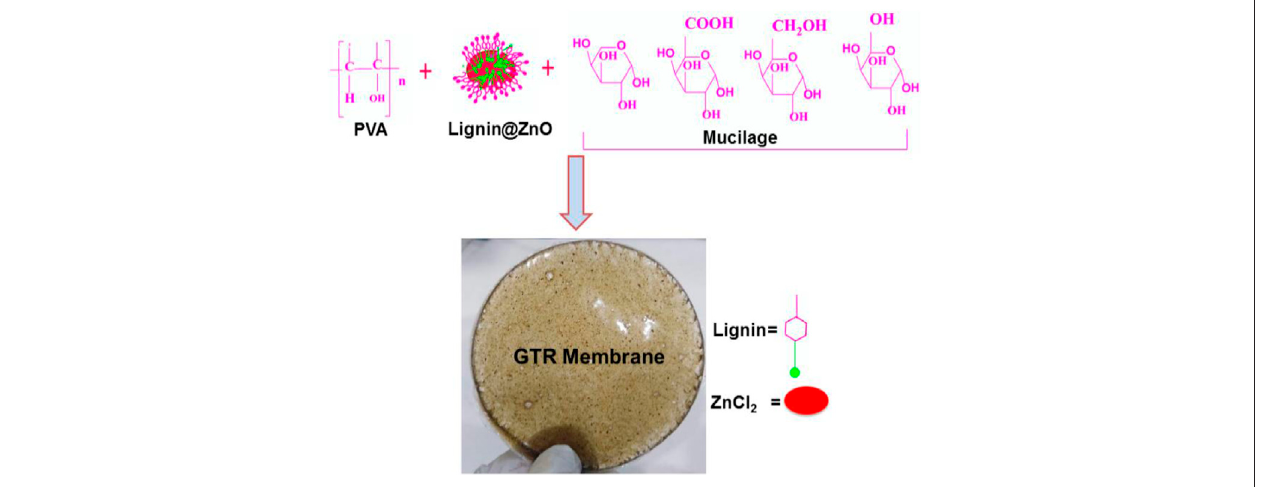
Scheme 1 | Schematic representation of the synthesis of GTR